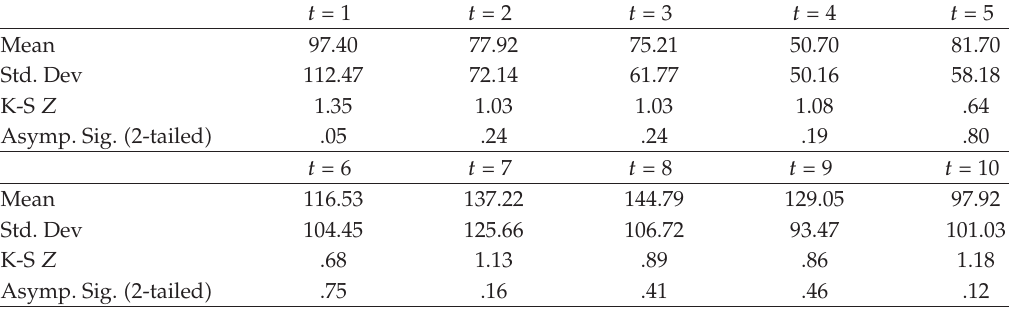
Table 1: Result of K-S testing against a normal distribution for a 10-second